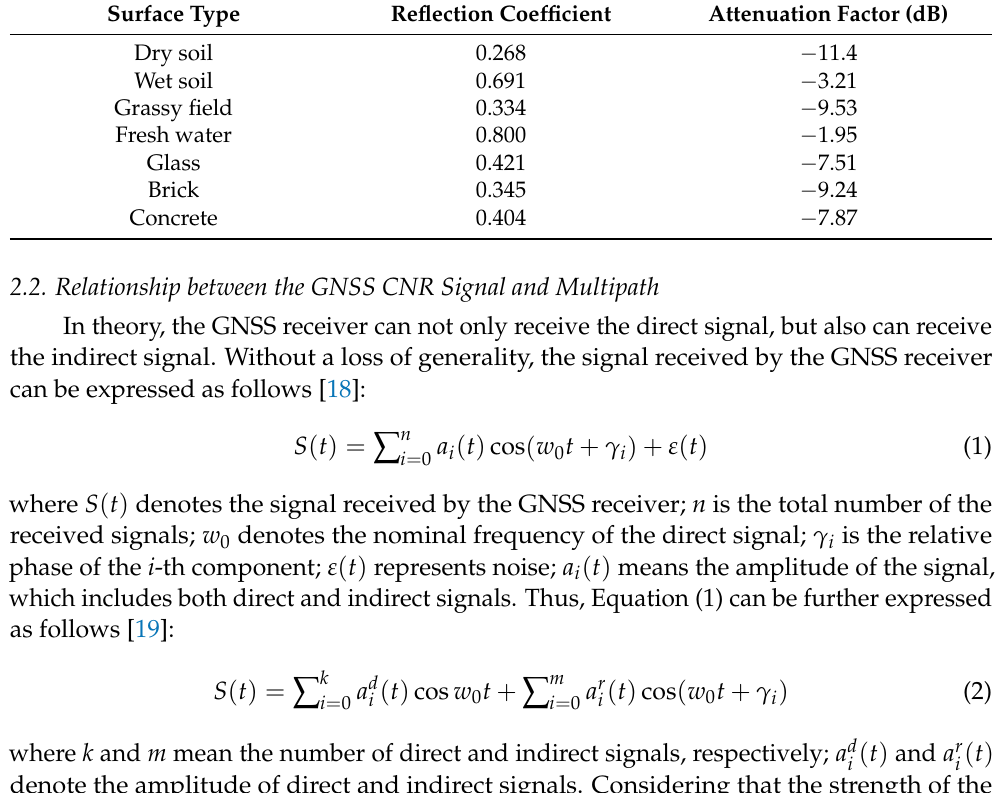
Table 1. Reflection coefficients and attenuation factors for common surfaces at normal incidences (elevation angle of 90 ◦ ) on a GPS L1 frequency. Surface